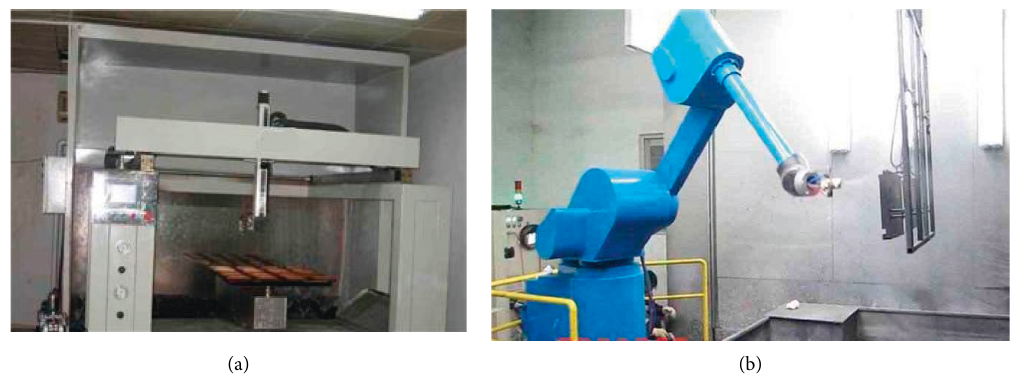
Figure 1: Automatic spraying equipment. (a) Automatic sprayer. (b) Spraying robot.